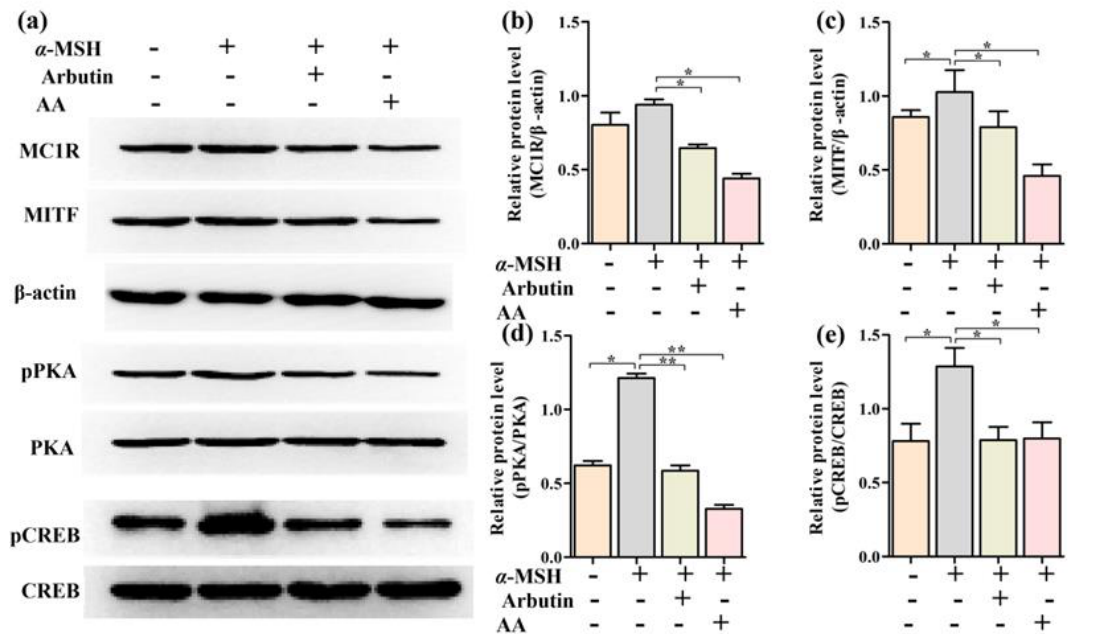
Figure 4. Effects of AA on the expression of MC1R, MITF, pPKA and pCREB of α -MSH-induced PIG1 cells ( a ). The levels of MC1R ( b ), MITF ( c ), pPKA ( d ) and pCREB ( e ) proteins were quantified by densitometry. Data are expressed as mean ± SEM. * p < 0.05, ** p < 0.01. ( n = 3 per group).